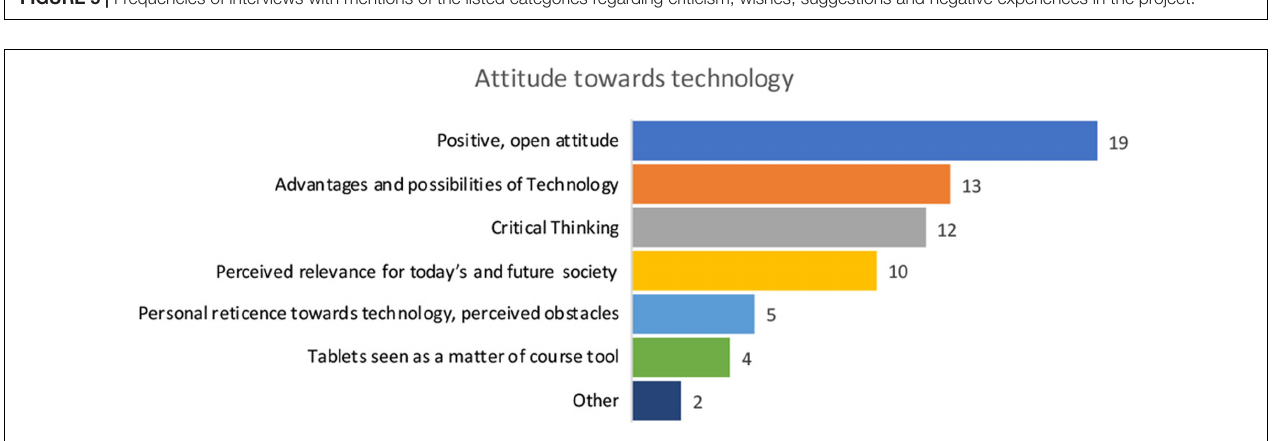
FIGURE 5 | Frequencies of interviews with mentions of the listed categories regarding criticism, wishes, suggestions and negative experiences in the project.